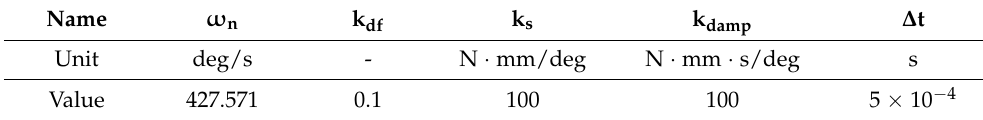
Table 2. Dynamic simulation